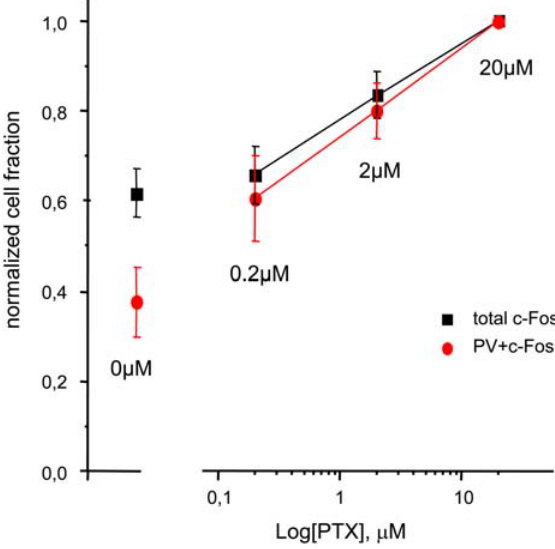
Figure 7. PV cells show c-Fos activation by PTX similar to the other cortical neurons. Dose-response curves after exposure to increasing concentrations (0, 0.2, 2, 20 m M) of PTX, showing comparable increases in c-Fos activation in the whole cortical cellular population (black) and in PVergic cells (red) (two-way ANOVA, effect of PTX concentration is significant with P=0.003, while no significant effect of cell type and no interaction between cell type and PTX dose was present, P . 0.05, N=4). Data are normalized to the value obtained with stimulation with 20 m M PTX.